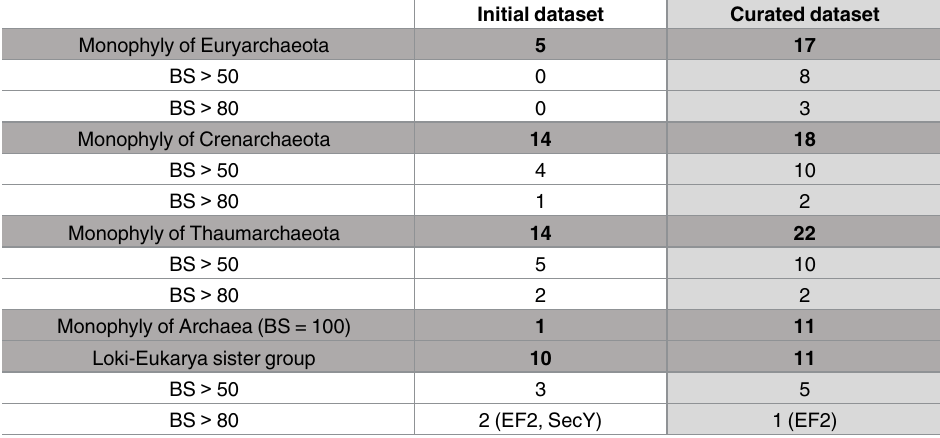
Table 1. Comparative analysis of the 36 individual phylogenetic trees obtained with the initial and the curated datasets. Initial dataset Curated dataset Monophyly of Euryarchaeota 5 17 BS > 50 0 8 BS > 80 0 3 Monophyly of Crenarchaeota 14 18 BS > 50 4 10 BS > 80 1 2 Monophyly of Thaumarchaeota 14 22 BS > 50 5 10 BS > 80 2 2 Monophyly of Archaea (BS = 100) 1 11 Loki-Eukarya sister group 10 11 BS > 50 3 5 BS > 80 2 (EF2, SecY) 1